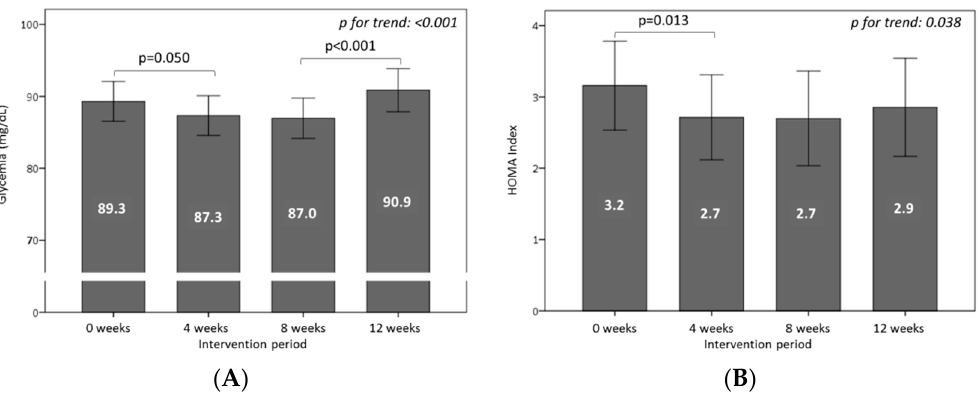
Figure 1. Effects of the consumption of burgers on ( A ) glycemia and ( B ) HOMA (homeostatic model assessment) throughout the study. Volunteers consumed one WGPF-burger daily between weeks 0 and 4 (intervention period), followed by a washout period (weeks 4 to 8), and then consumed one control-burger daily between weeks 8 and 12 (control period). Bars represent the mean value for each time. Lines represent the 95% confidence interval. Analysis of variance (ANOVA) of four repeated measures with the repeated contrast method was used to evaluate changes between the 4-week intervention periods over time.